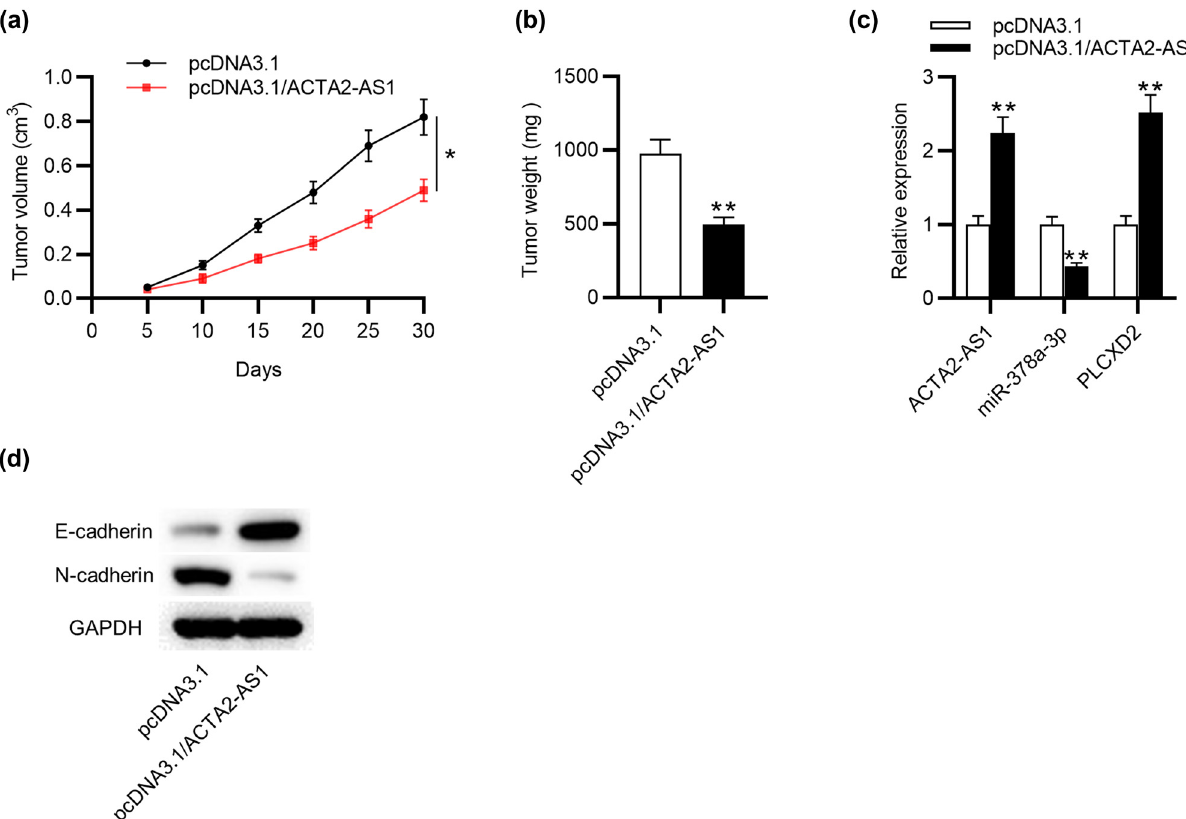
Figure 6: ACTA2 - AS1 inhibits xenograft tumor growth in vivo. ( a ) After implantation of transfected cells, tumor volume was measured every 5 days. ( b ) After the mice were euthanized 30 days after implantation, tumors were weighed. ( c ) RT - qPCR was conducted to examine expression levels of ACTA2 - AS1, miR - 378a - 3p, and PLCXD2 in tumor tissues. ( d ) Protein levels of EMT markers ( E - cadherin and N - cadherin ) in tumor cells were detected by Western blot analyses. * p < 0.05 and ** p <